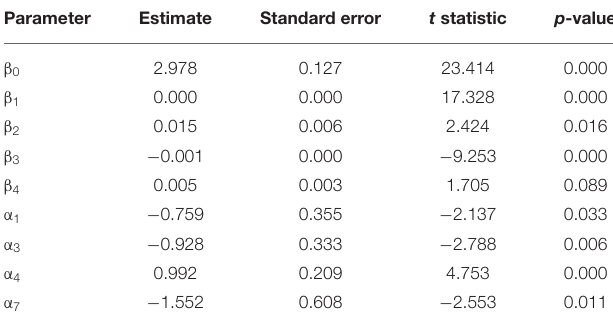
TABLE 1 | Results of the final normal